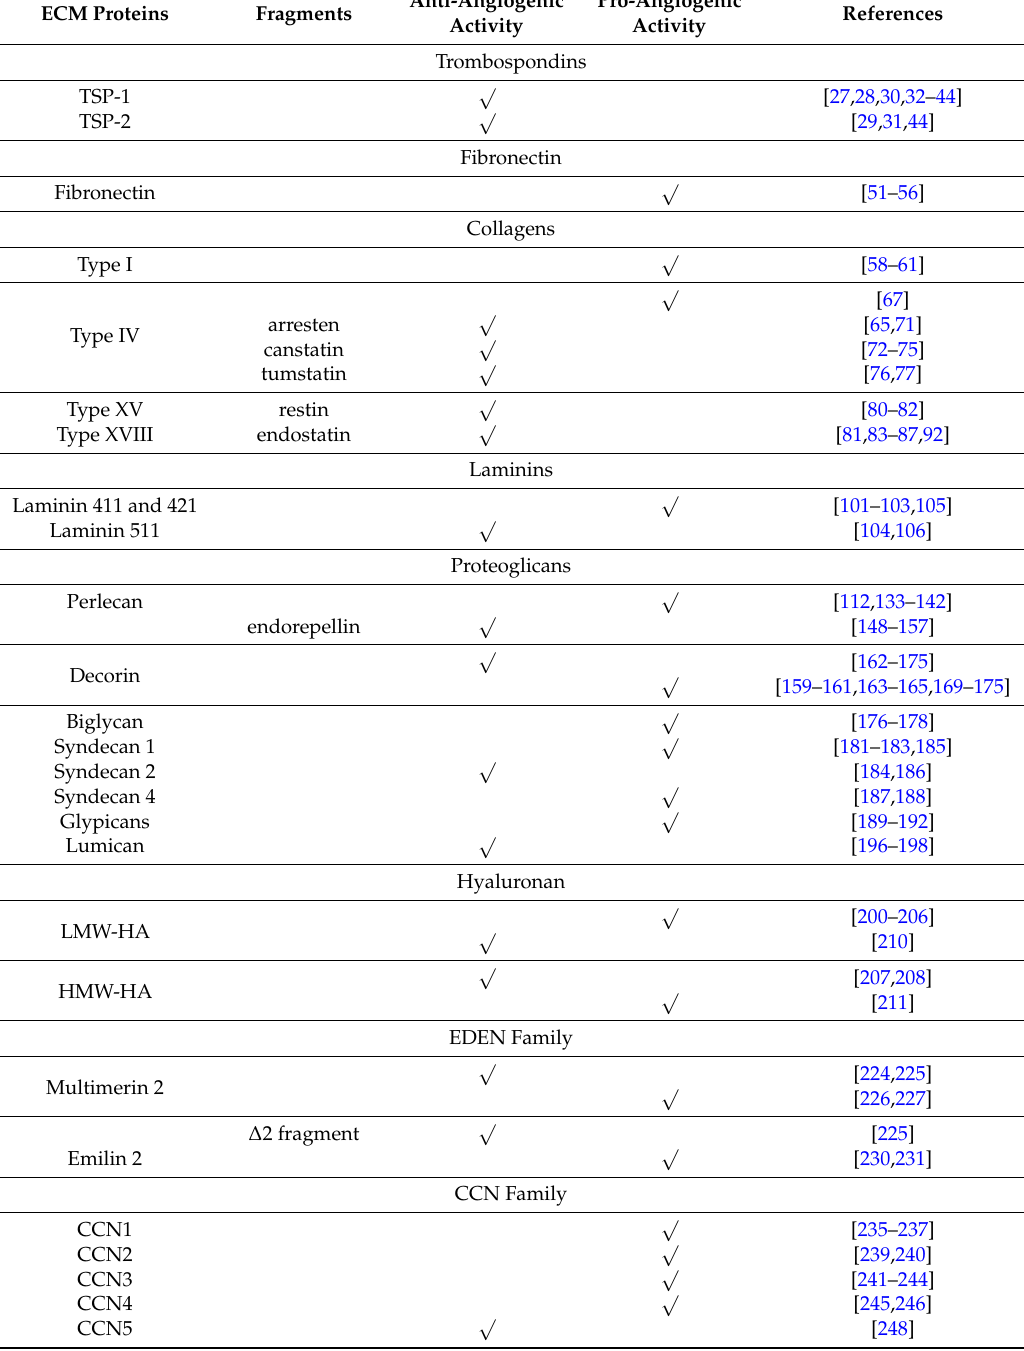
Table A1. List reporting the main ECM molecules involved in